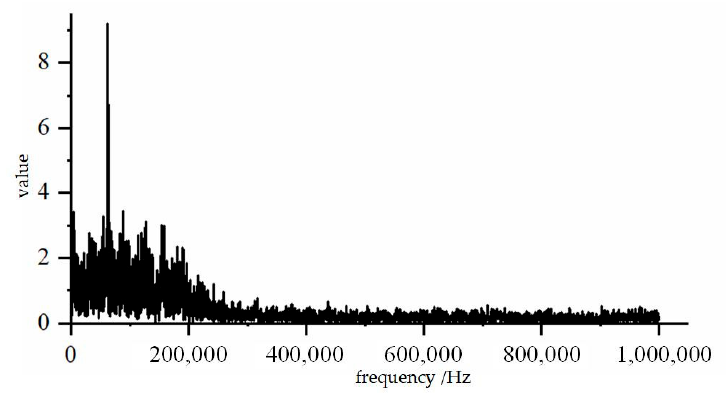
Figure 5. Result of noise sampling.